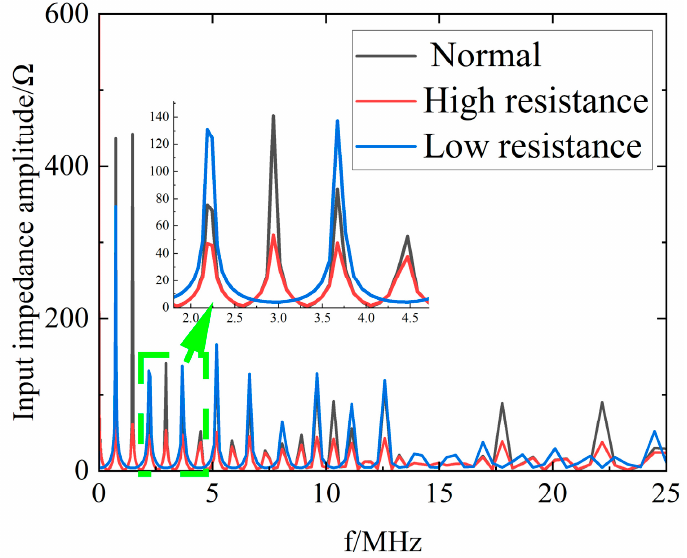
Figure 5. Headend input impedance amplitude spectrum of normal operation, high resistance, and low resistance cables.